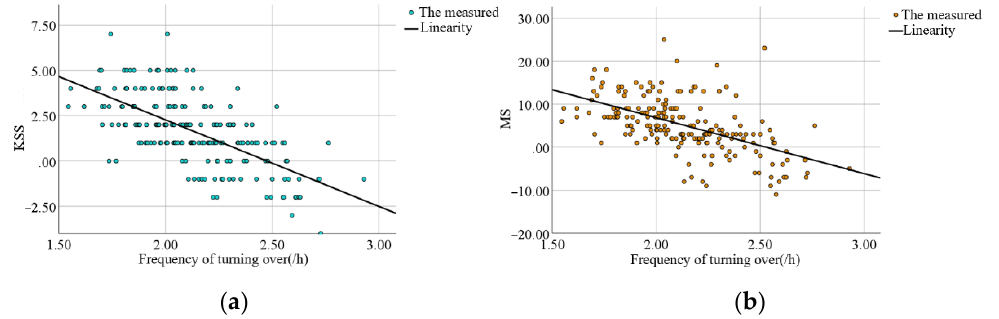
Figure 10. The plot of the relationship between turning-over frequency and subjective sleep quality: ( a ) the scatter plot of the difference between tossing frequency and morning and evening sleepiness (KSS score); ( b ) the scatter plot of tossing frequency and fatigue status (MS score).